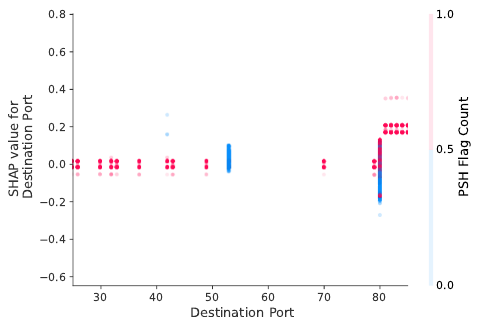
Figure 6. PSH Flag Count/Destination Port interaction for benign network.